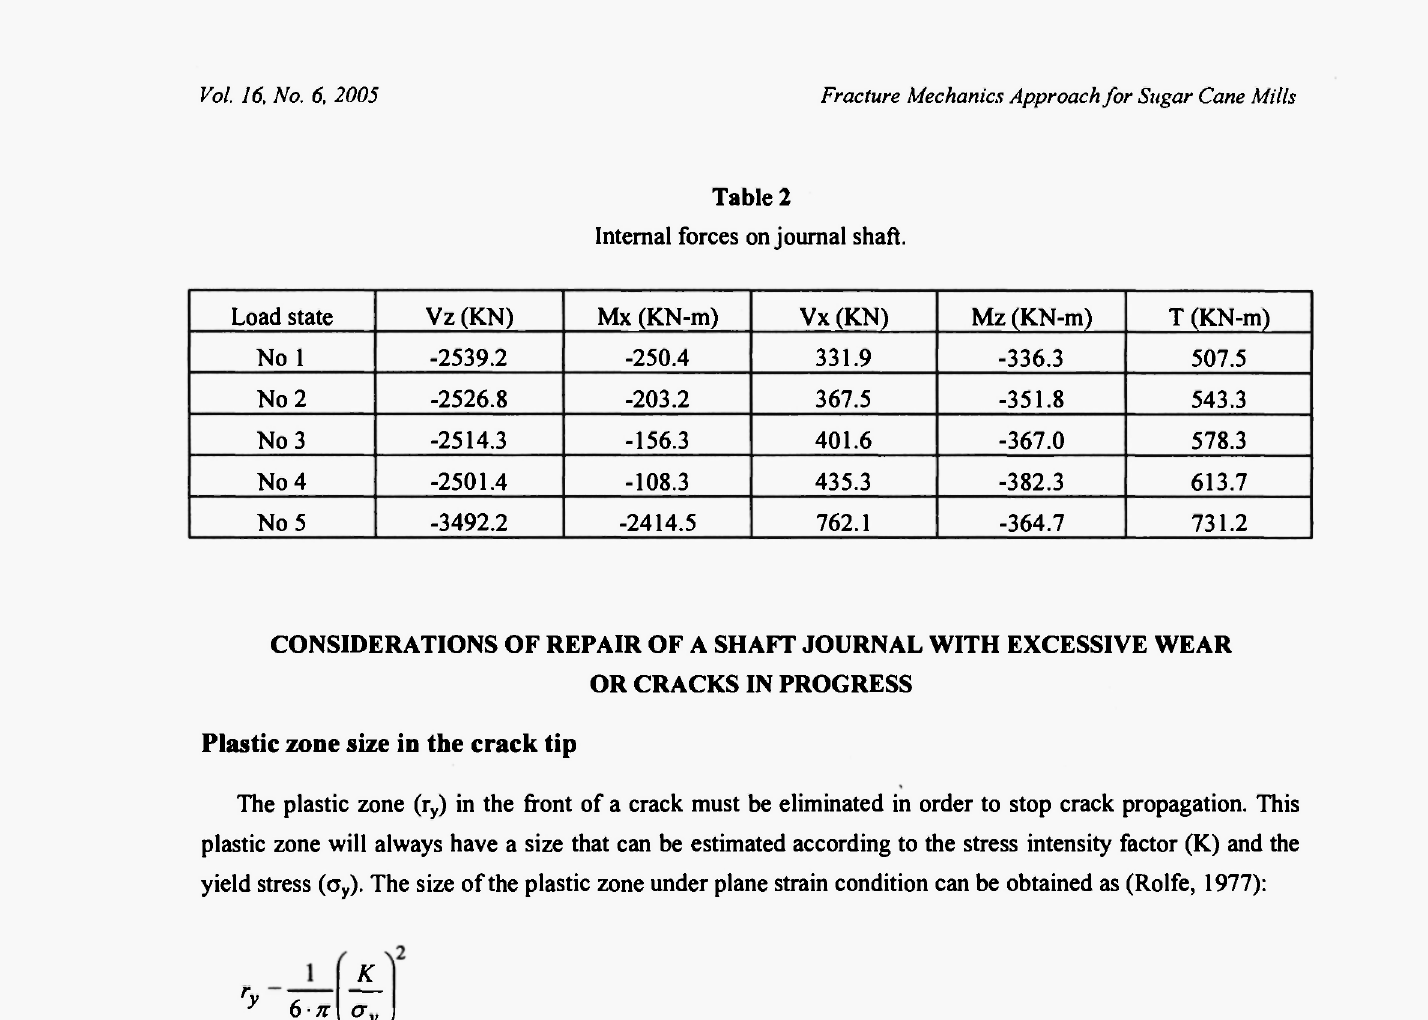
Internal forces on journal shaft.